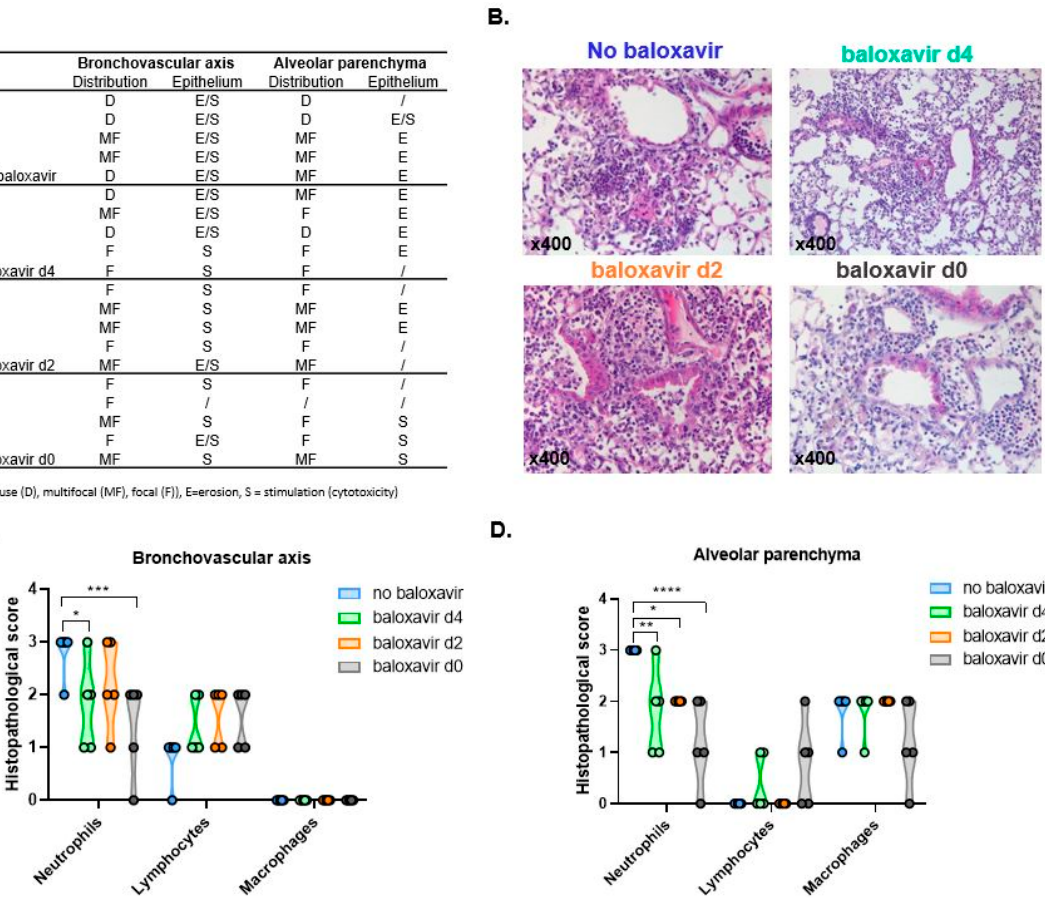
Figure 5. Baloxavir marboxil treatment onset-dependent reduction in lung pathology ( A ) Histopatho- logical scores including the type of distribution (diffuse (D), multifocal (MF), focal (F)) for n = 5 mice per group. ( B ) Histological hematoxylin and eosin (H&E) staining (magnification × 400) of no balox- avir marboxil, baloxavir marboxil from day 4, baloxavir marboxil from day 2 and baloxavir marboxil from day 0. ( C , D ) Histological general inflammatory subset analysis (neutrophils, macrophages, lym- phocytes) in bronchovascular axis ( C ) and alveolar parenchyma ( D ) from non-treated (no baloxavir, blue, n = 5 mice), baloxavir marboxil from day 4 (green, n = 5 mice), baloxavir marboxil from day 2 (orange, n = 5 mice) and baloxavir marboxil from d0 (grey, n = 5 mice). Differences were considered significant if p was smaller or equal to 0.05. * p < 0.05, ** p < 0.01, *** p < 0.001, **** p < 0.0001. Data are represented as mean ±